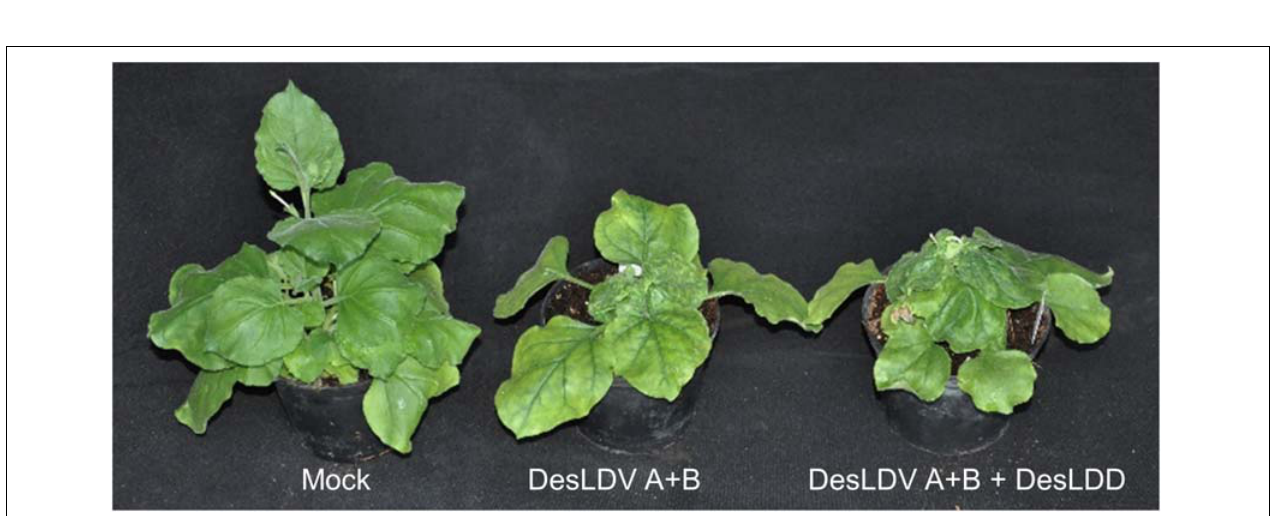
FIGURE 7 | Symptoms of leaf distortion and a significant reduction in plant growth developed in Nicotiana benthamiana plants agroinoculated with Desmodium leaf distortion virus (DesLDV) DNA-A and DNA-B, alone or in combination with Desmodium leaf distortion deltasatellite (DesLDD). Mock-inoculated control is shown at the left of the